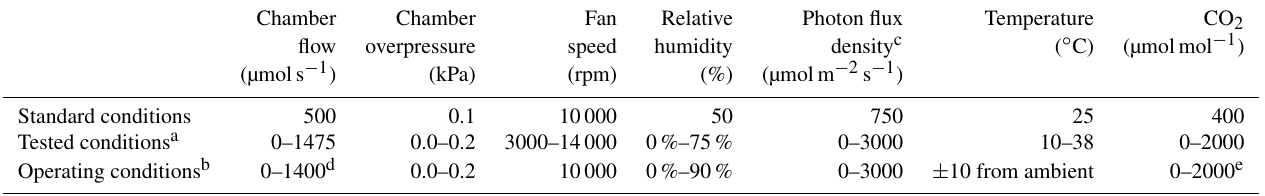
Table 1. User-defined standard, tested, and operating conditions of environmental controls using the LI-6800. Chamber Chamber Fan Relative Photon flux Temperature CO 2 flow overpressure speed humidity density c